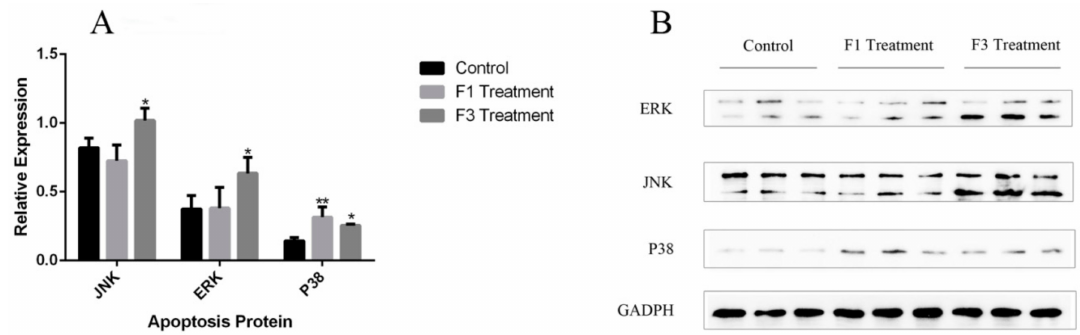
Figure 11. The relative expression level of apoptosis-related proteins ( A ) (comparing with control group, * p ≤ 0.05; ** p ≤ 0.01); ( B ) The graph of